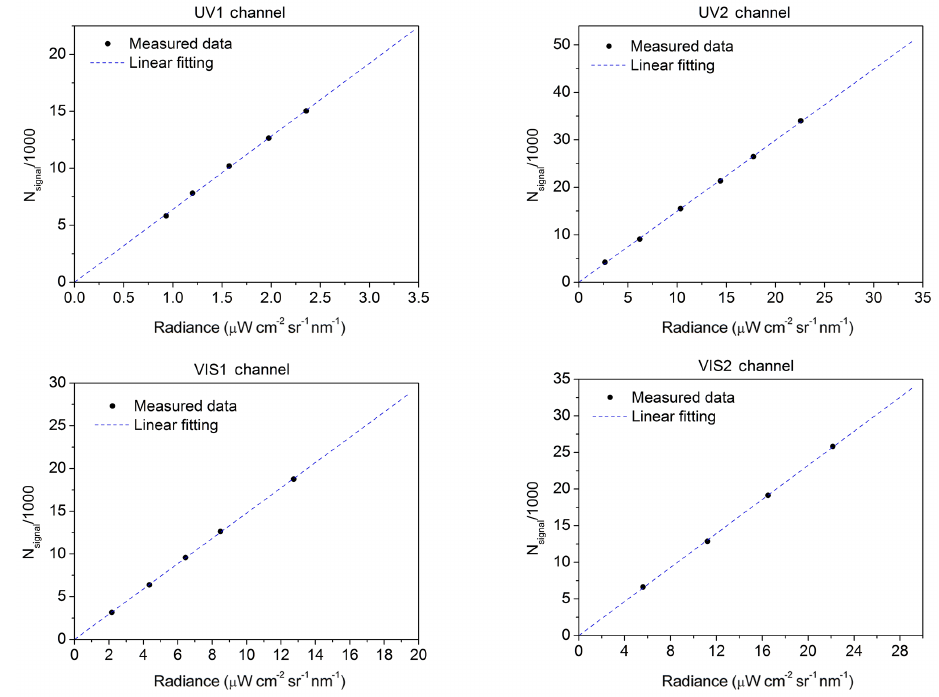
Figure 10. Linear response of the EMI, the signal is corrected by the dark signal. A non-linear response region exists under very low light signal (equal to the dark signal) condition and high light signal (saturation light signal) condition. The integration time, CCD readout, and gain steps are set up to ensure that the EMI works in the linear response region.